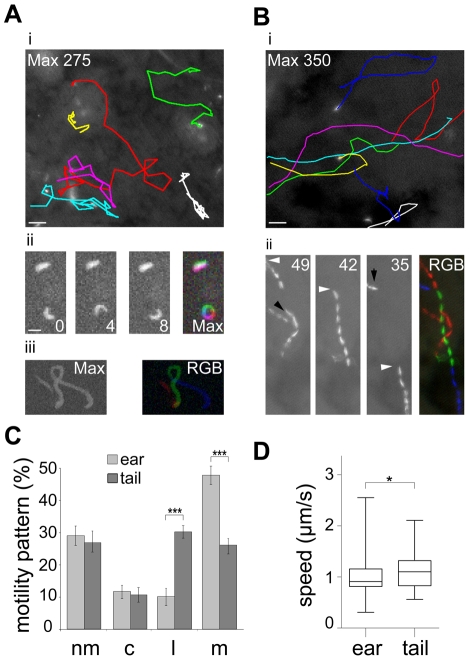
Different patterns of P. berghei sporozoite migration in the skin.(A) Sporozoites gliding within the skin of the ear. i: Colored tracks of 6 gliding sporozoites over 275 s (see Video S1) . Scale bar: 25 µm. ii: single frames and maximum fluorescent intensity projection of an immotile and a circular gliding sporozoite. Scale bar: 10 µm. iii: projection of a meandering sporozoite (left: max projection over 82 s; right: pseudo-colored track (RGB) of three different time periods of the same acquisition). Time is indicated in seconds. (B) Sporozoites gliding within the skin of the tail. i: Colored tracks of 8 gliding parasite over 350 s (see Video S1). Scale bar: 25 µm. ii: projection of three different time periods within one acquisition and the pseudo-colored merge (RGB) of these projections. White arrowheads point to the same parasite during the acquisition; black arrowheads point to the paths of other parasites. Time is indicated in seconds. (C) Automatically detected motility patterns of sporozoites imaged in the skin of the ear (n = 589) and tail (n = 164) showing a preference for meandering and linear movement patterns in the ear and tail, respectively, *** indicates P<0.001, motility patterns: nm = non motile; c = circling; l = linear; m = meandering. (D) Speed plot showing the median speed distribution of all tracked parasites imaged at 0.2 Hz in the dermis of ear or tail; whiskers and box indicate 97.5% and 50% of all values, respectively; horizontal bar: median (ear: 0.91 µm/s; tail: 1.10 µm/s; * indicates P<0.05).